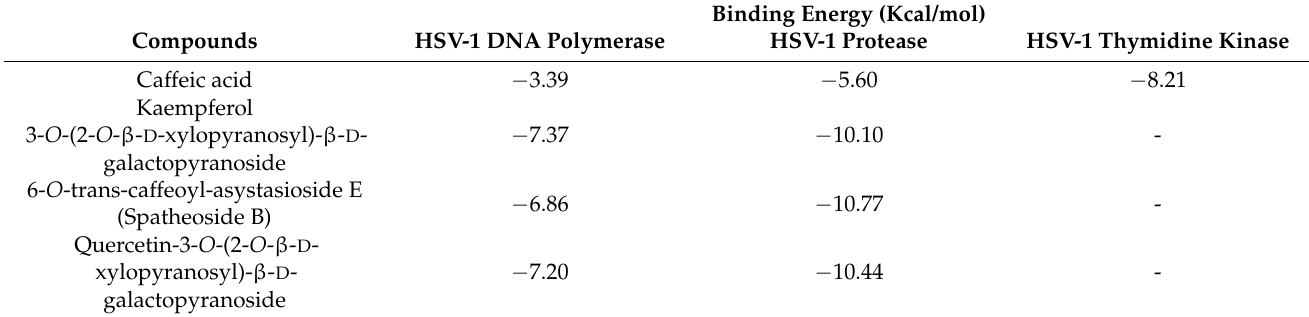
Table 5. The binding energy of bioactive compounds for the HSV-1 target proteins. No possible binding poses of kaempferol 3- O -(2- O - β - D -xylopyranosyl)- β - D -galactopyranoside, 6- O -trans-caffeoyl- asystasioside E (spatheoside B), or quercetin-3- O -(2- O - β - D -xylopyranosyl)- β - D -galactopyranoside to HSV-II thymidine kinase were found. Binding Energy